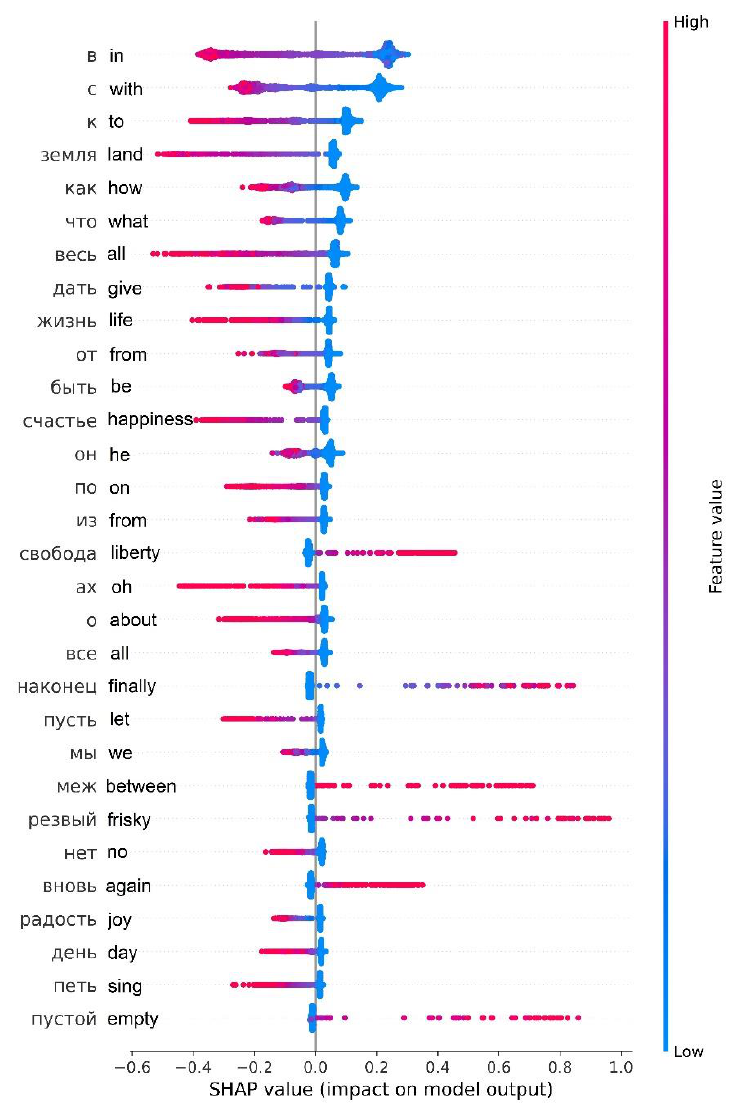
Figure 3. Distribution of the influence of the features on the results of classification by words in the initial form. Table 7. The classification results by service and short words for the main data set.